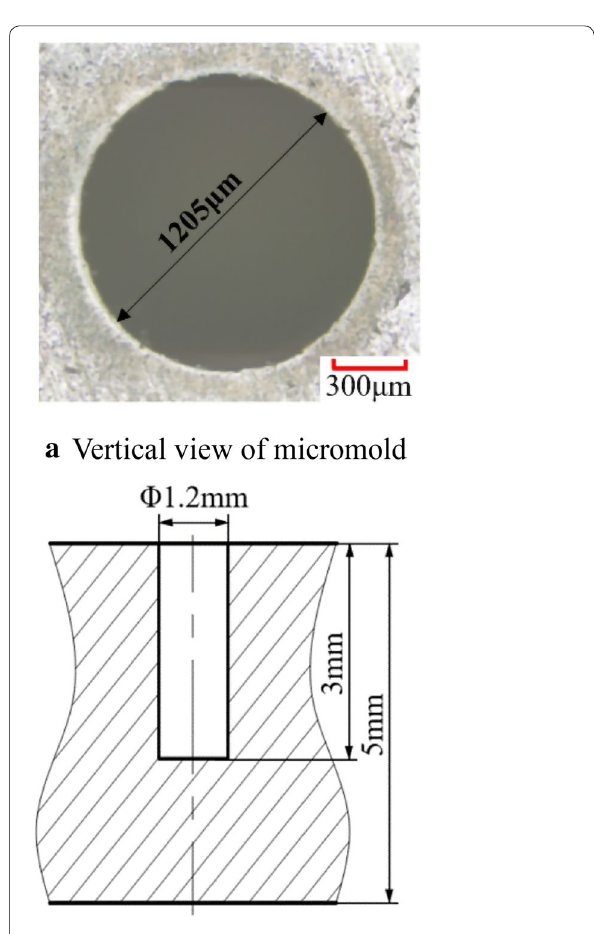
Figure 5 Structure and size diagram of micromold